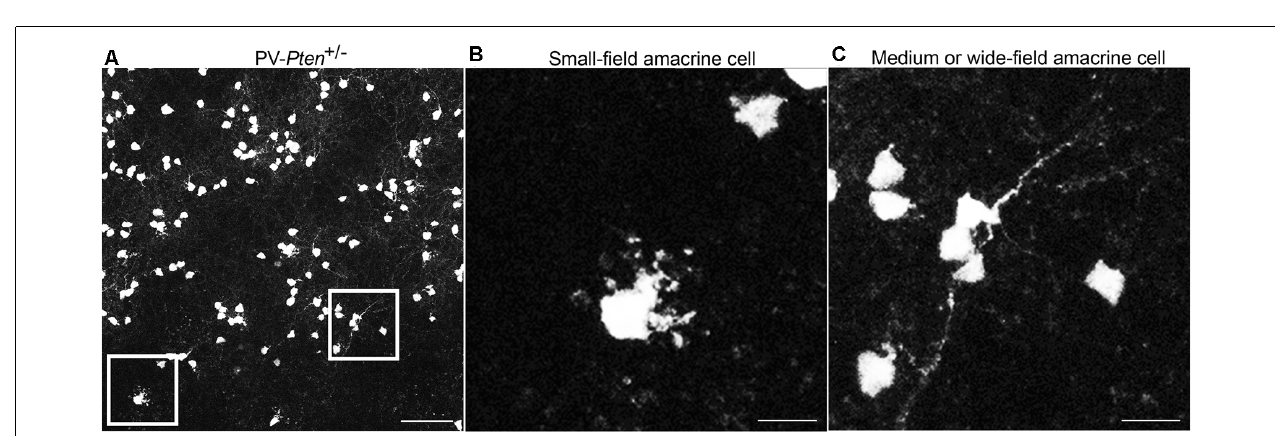
FIGURE 1 | TdTomato fluorescence in the retina ganglion cell layer (GCL) of PV- Pten mice at 1.0 mm from the optic nerve head. TdTomato fluorescence was observed in cell bodies, dendrites, and axons with the strongest expression in the cell bodies. (A) TdTomato fluorescence in the GCL of a PV- Pten +/+ mouse. (B) TdTomato fluorescence in the GCL of a PV- Pten +/- mouse. (C) Histogram indicating the mean ( ± SEM) density of tdTomato fluorescent cell bodies per mm 2 in the GCL. z-step = 1 µ m. Five optical sections were compressed for viewing. n.s., not significant. Scale bar: 50 µ m.